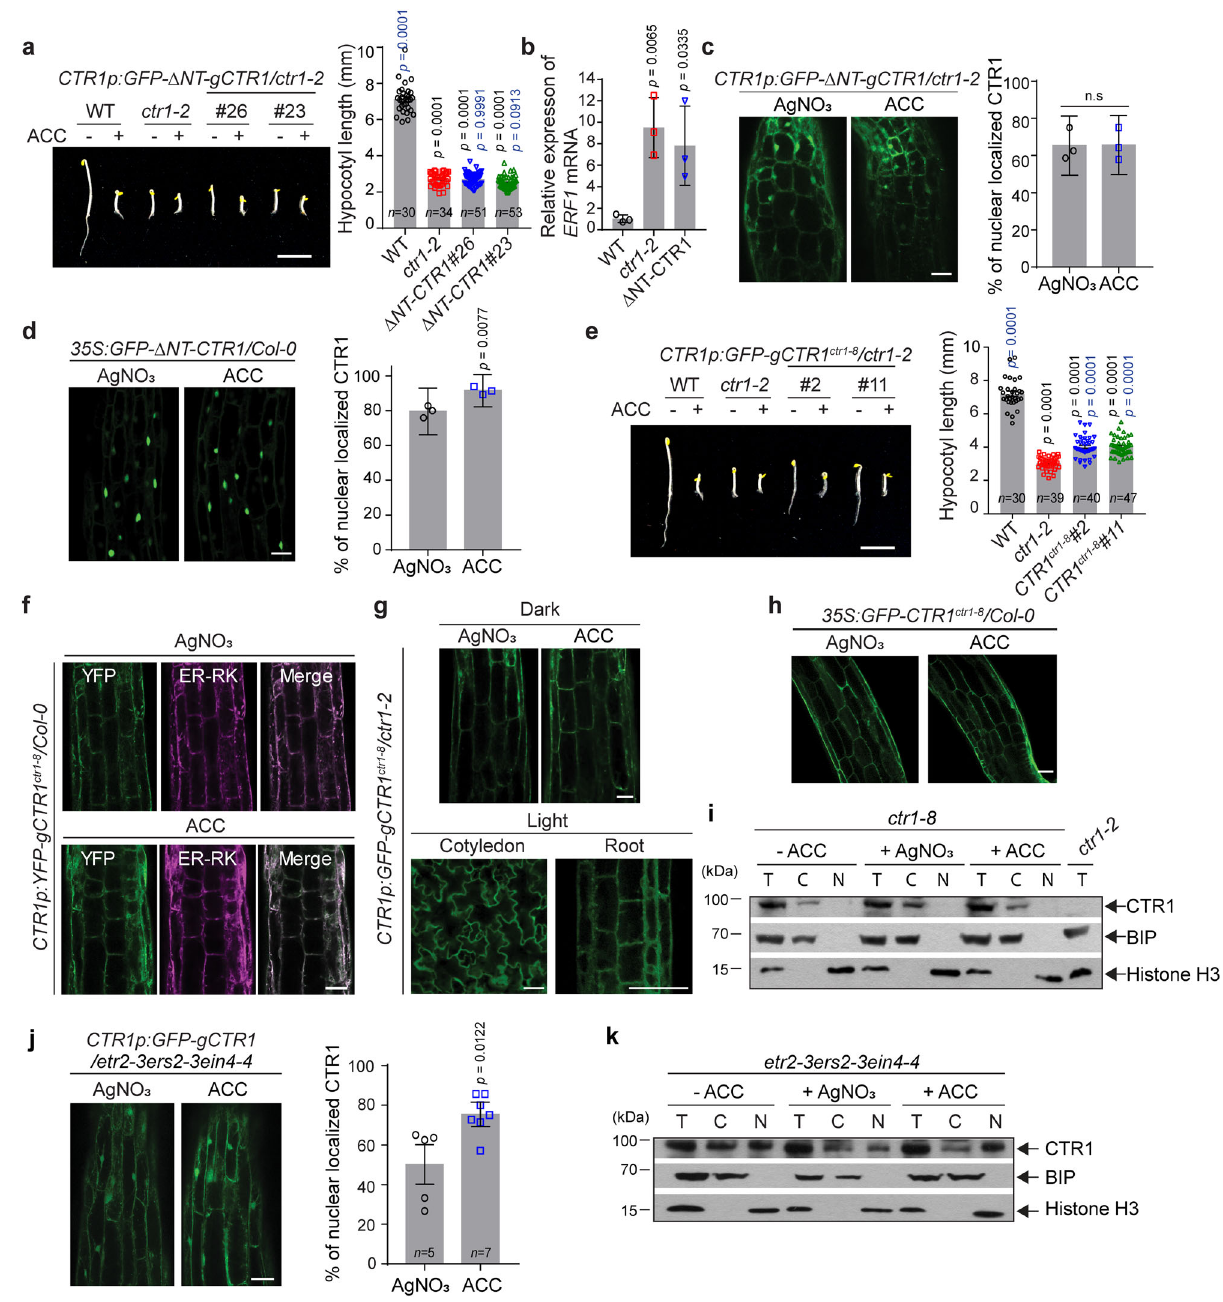
Fig. 2 | The N-terminusofCTR1inhibits ACC-inducedCTR1 nuclearmovement. a Seedlings were grown on MS medium with or without 10 μ M ACC for 3 d and photographed. The graph shows quanti fi cation of the hypocotyl lengths of seed- lings grown on MS without ACC. Scale bar, 5mm. Signi fi cance was determined by one-way ANOVA with Dunnett ’ s multiple comparisons test to compare the results to the WT (black) and ctr1-2 (blue) controls. Error bars, SE. b Quantitative gene expressionanalysisofethylene-responsive ERF1 in ctr1-2 and CTR1p:GFP- Δ NT-gCTR1 seedlings. Expression was normalized to an Actin control and is presented relative totheWTcontrol.Errorbars,SD( n =3biologicalreplicates). c Constitutivenuclear localization of GFP- Δ NT-CTR1 expressed from the native promoter in the hypo- cotylsof dark-grownseedlings. The graphrepresents the ratio of nuclear-localized CTR1 in dark-grown seedlings treated with ACC or AgNO 3 . Error bars, SE ( n =3 seedlings). d Constitutive nuclear localization of GFP- Δ NT-CTR1 expressed fromtheCaMV35Spromoterin3-d-olddark-grown.Thegraphrepresentstheratio of nuclear-localized CTR1 in dark-grown seedlings treated with ACC or AgNO 3 .